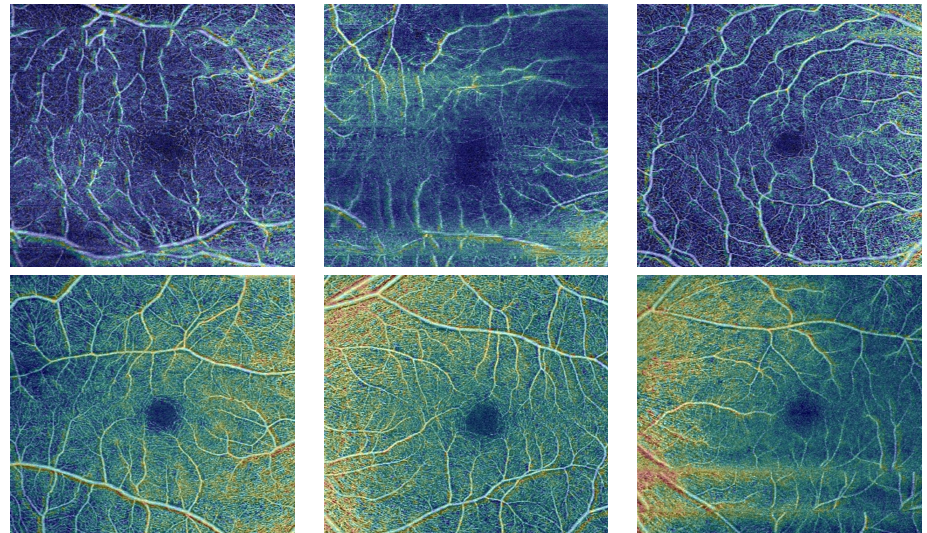
Figure 9. Network attention maps showing the difference between the DR and NDR cases, in the first and second row, respectively.